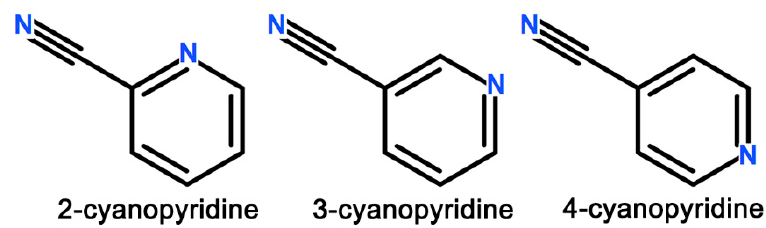
Figure 1. Molecular structure diagrams of the three cyanopyridine additives.